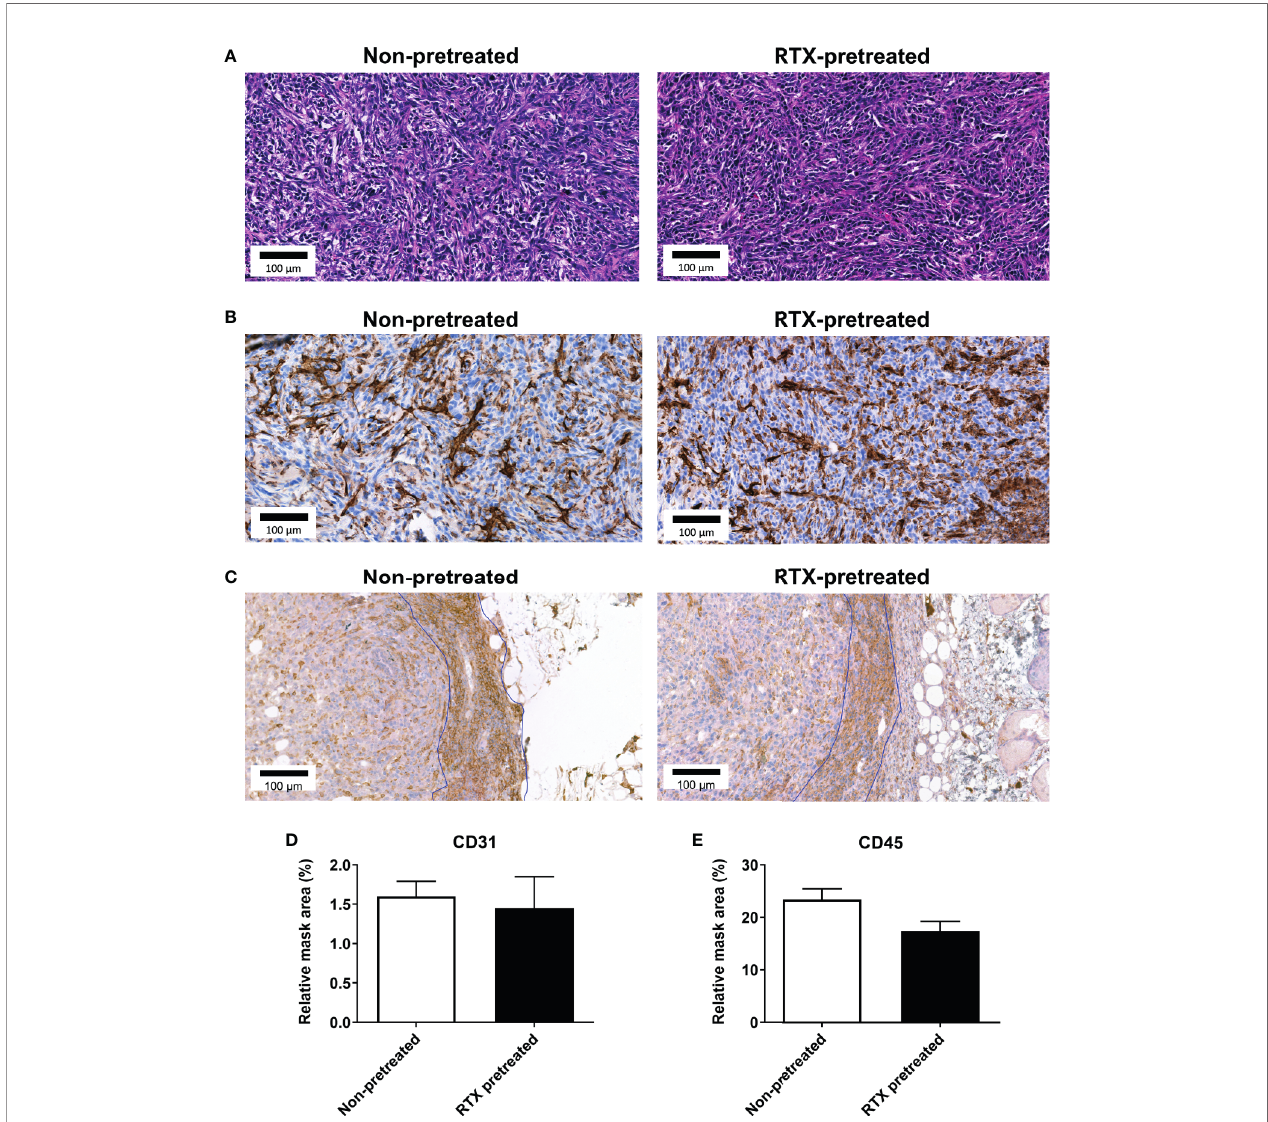
FIGURE 6 | No signi fi cant difference observed in in CD31 and CD45 immunoreactivity of the 4T1 tumor tissue in RTX-pretreated mice. (A) Representative H&E and (B) anti-CD31 stained histopathological slides with high magni fi cation (23x). (C) Representative anti-CD45 stained slides with high (23x) magni fi cation. (D) CD31 expression measured by quantitative immunohistochemistry (relative mask area %). (E) CD45 expression measured by quantitative immunohistochemistry (relative mask area